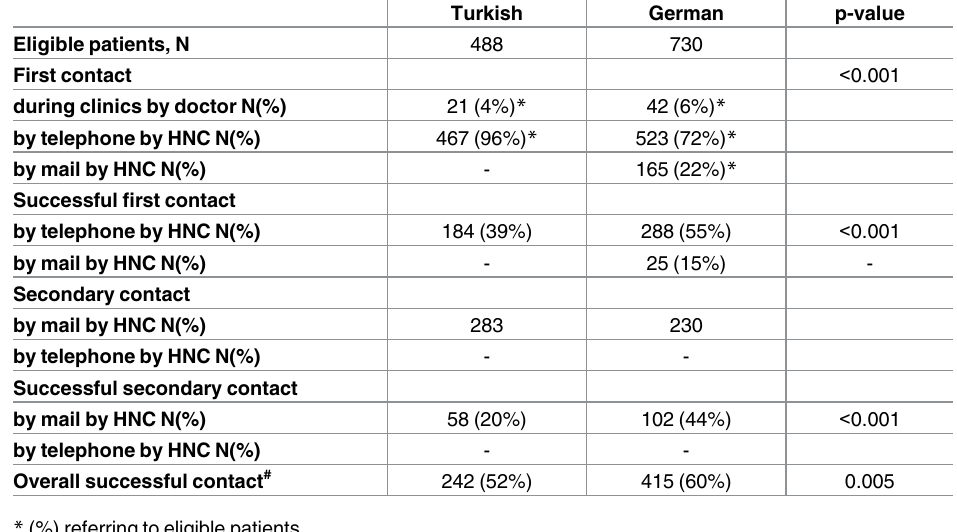
Table 1. Mode and successof contacting eligible Turkish and German patients in ambulatory